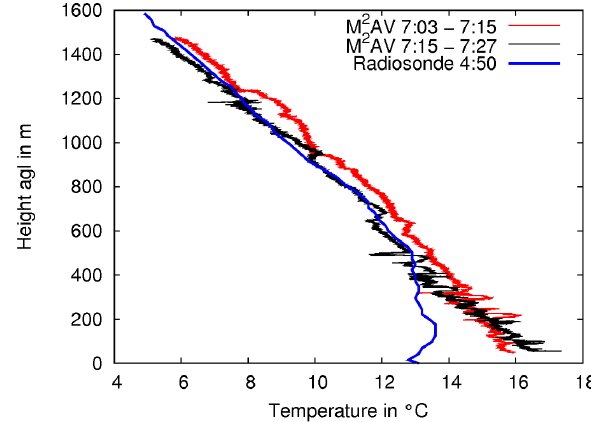
Fig. 5. Comparison of radiosonde data measured at 04:50UTC and M 2 AV data measured between 07:03UTC and 07:27UTC on 21 July